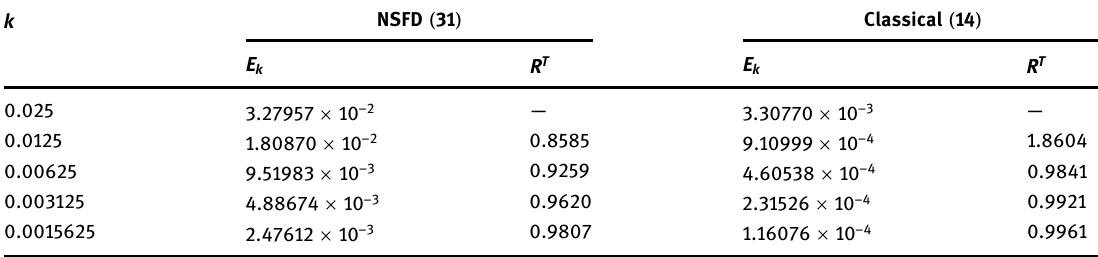
Table 2: Rate of convergence in time using experiment 1 for NSFD and classical for = h 0.02 at time = t 1.0